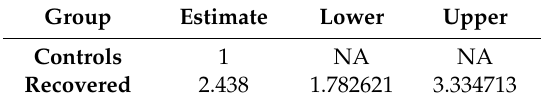
Table 3. Risk ratio related to symptoms in recovered patients. Risk ratio with 95% C.I. Group